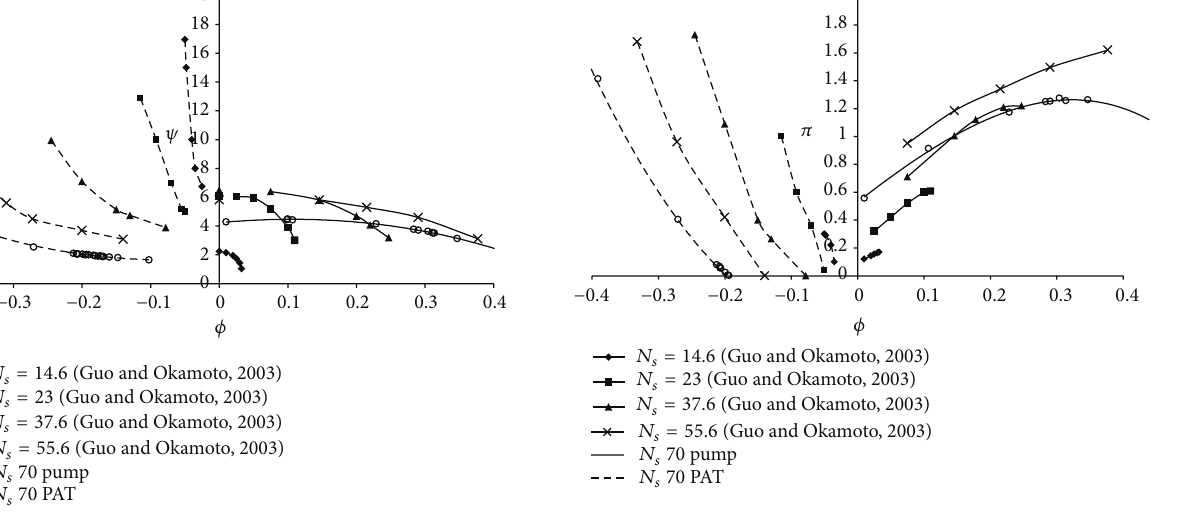
Figure 3: Dimensionless power curves of PAT in pump and turbine modes—comparison to Derakshan et al.